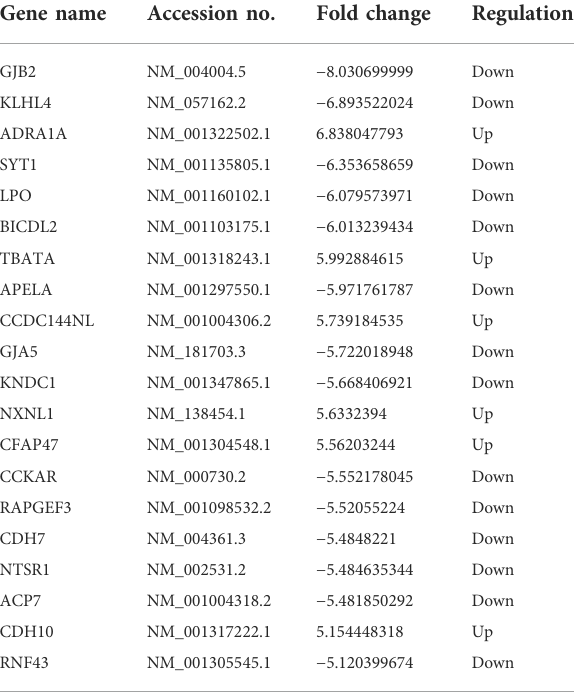
TABLE 1 The characteristics of the top 20 mRNA with largest fold change.